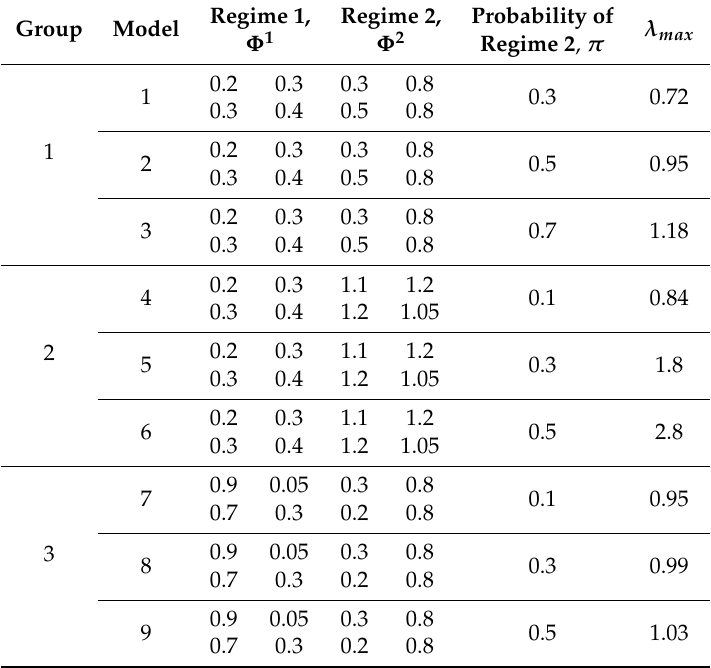
Table 1. Parameter values used in simulating the bivariate TVAR model. Regime 1, Regime 2, Probability of Group Model